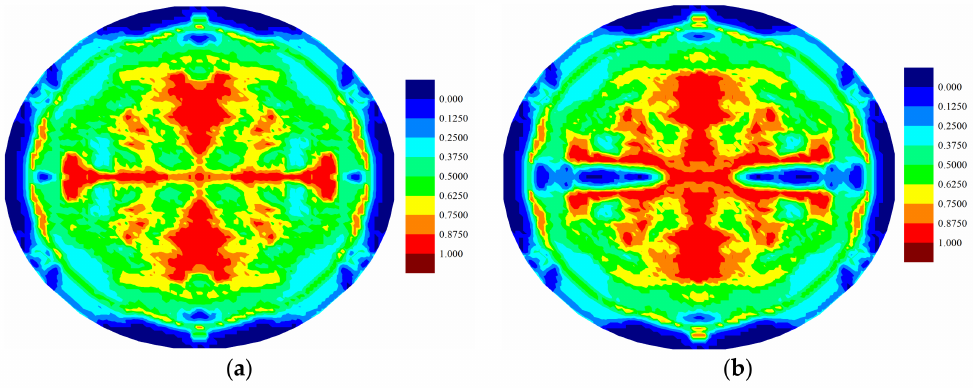
Figure 17. Matrix damage comparison of bottom ply for ( a ) coupled case and ( b ) uncoupled case at 0.3461 × 10 − 3